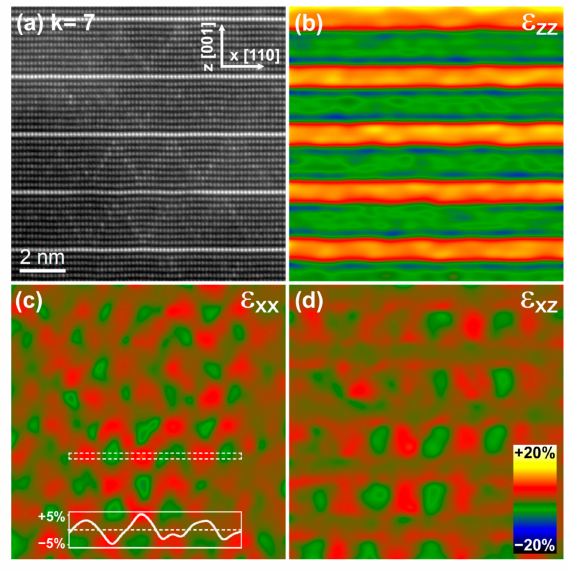
Figure 6. ( a ) High-resolution HAADF-STEM image of the k = 7 term obtained from aligning and averaging a series of 10 short-exposure images. Note the presence of the zig-zag modulation with a brighter contrast in the wurtzite-type blocs. ( b – d ) Corresponding ε zz , ε xx , and ε xz strain maps obtained by GPA. The inset in panel ( c ) is the line profile of the ε xx strain component extracted along the white dashed box. The color bar gives the change in strain.